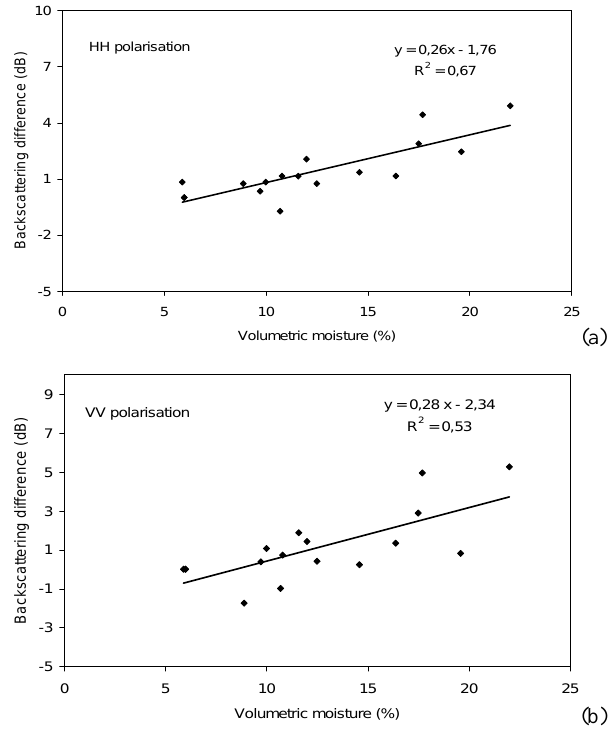
Fig. 4. Processed ENVISAT ASAR signals (in decibels) versus measured volumetric moisture over olive tree fields, (a) HH polar- ization, (b) VV